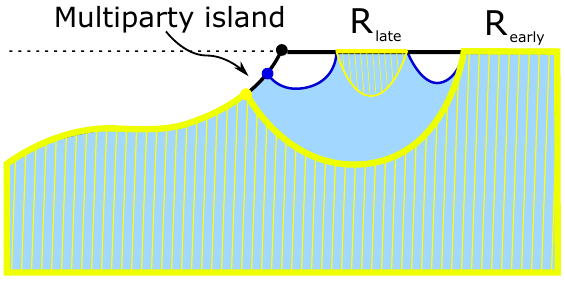
Figure 20 . We can divide the radiation into early and late parts in the model of [3]. The entanglement wedge of the union (blue shading) has the structure of a multiboundary wormhole, albeit in one higher dimension than where the black hole lives. Having access to only the early radiation gives a partial island (where the yellow hatched region meets the Planck brane), the remaining multiparty island is only accessible by having control over R early and R late